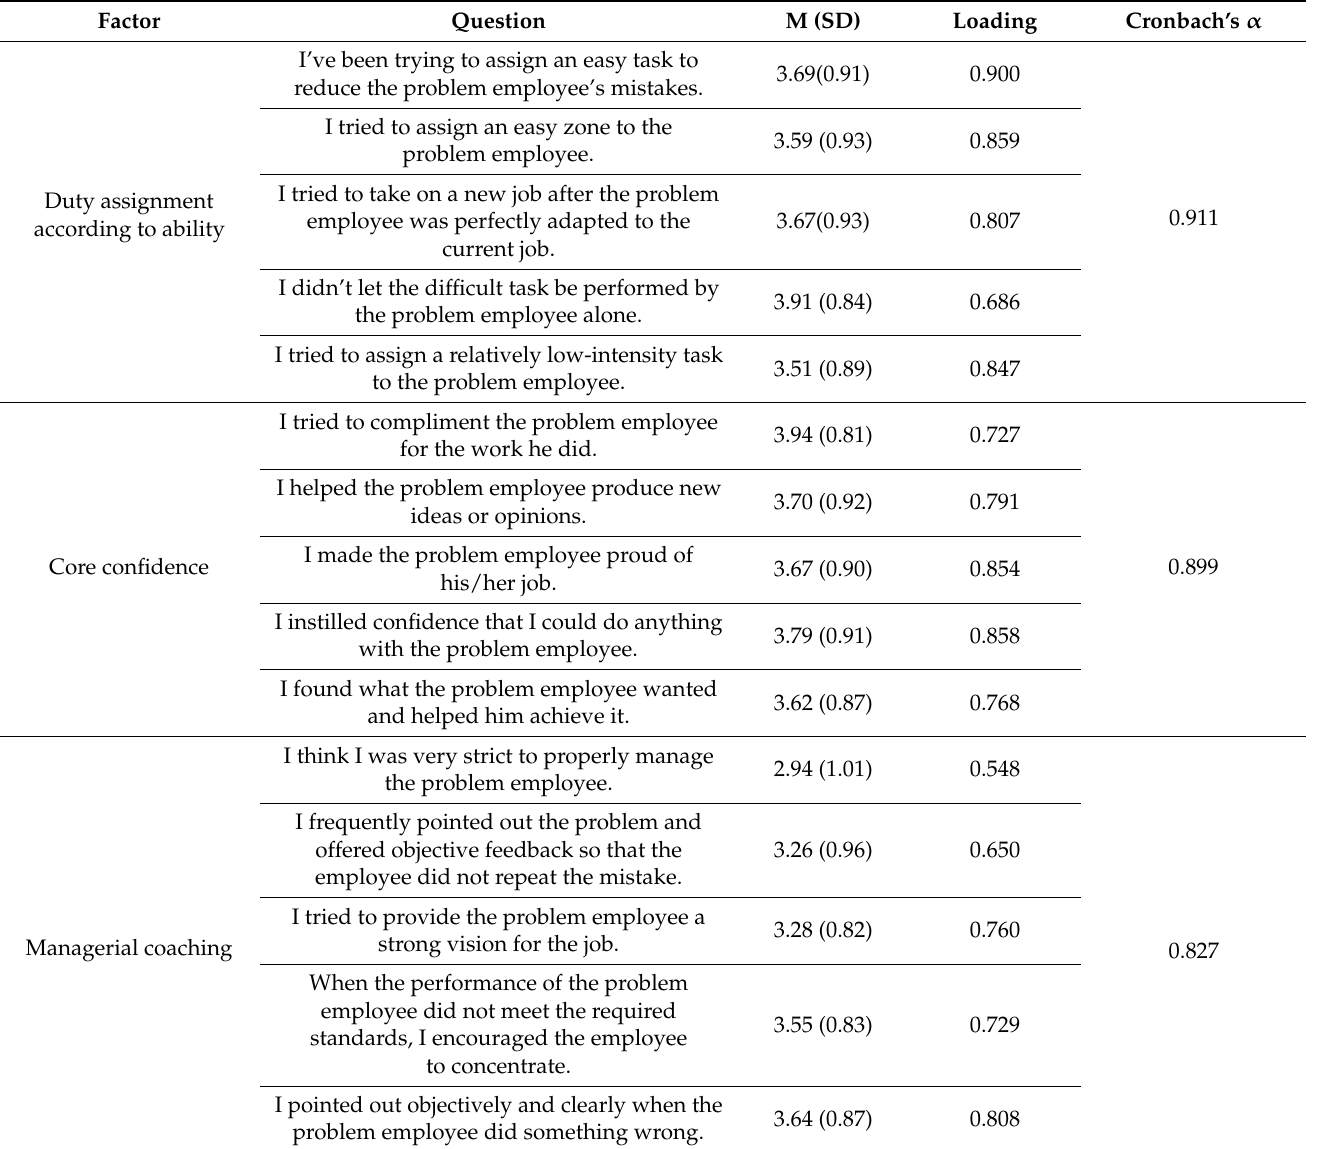
Table 2. Results of CFA and Reliability